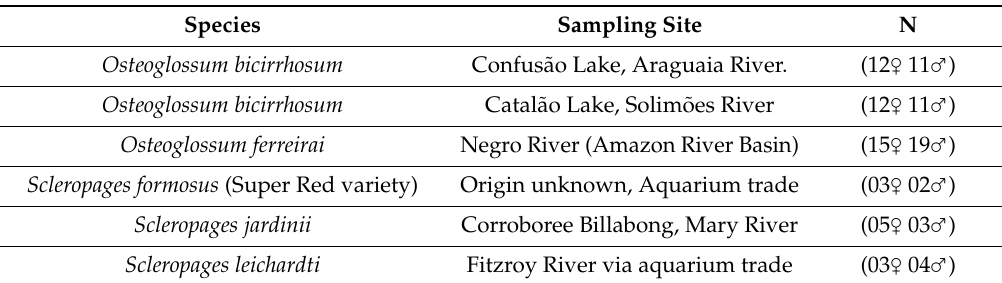
Table 1. Collection sites of the Arowana species analyzed, with the sample sizes